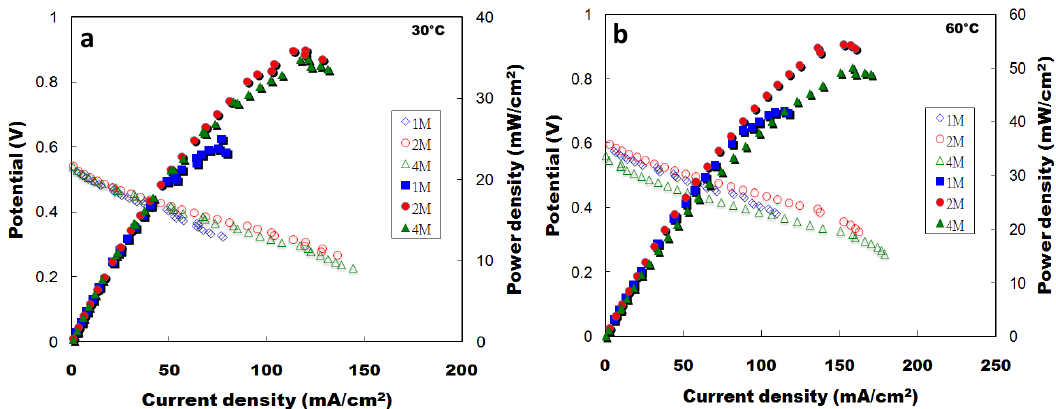
Figure 10. Methanol cell performance of pristine QPVA membranes at ( a ) 30 °C and ( b ) 60 °C with 6 M KOH.